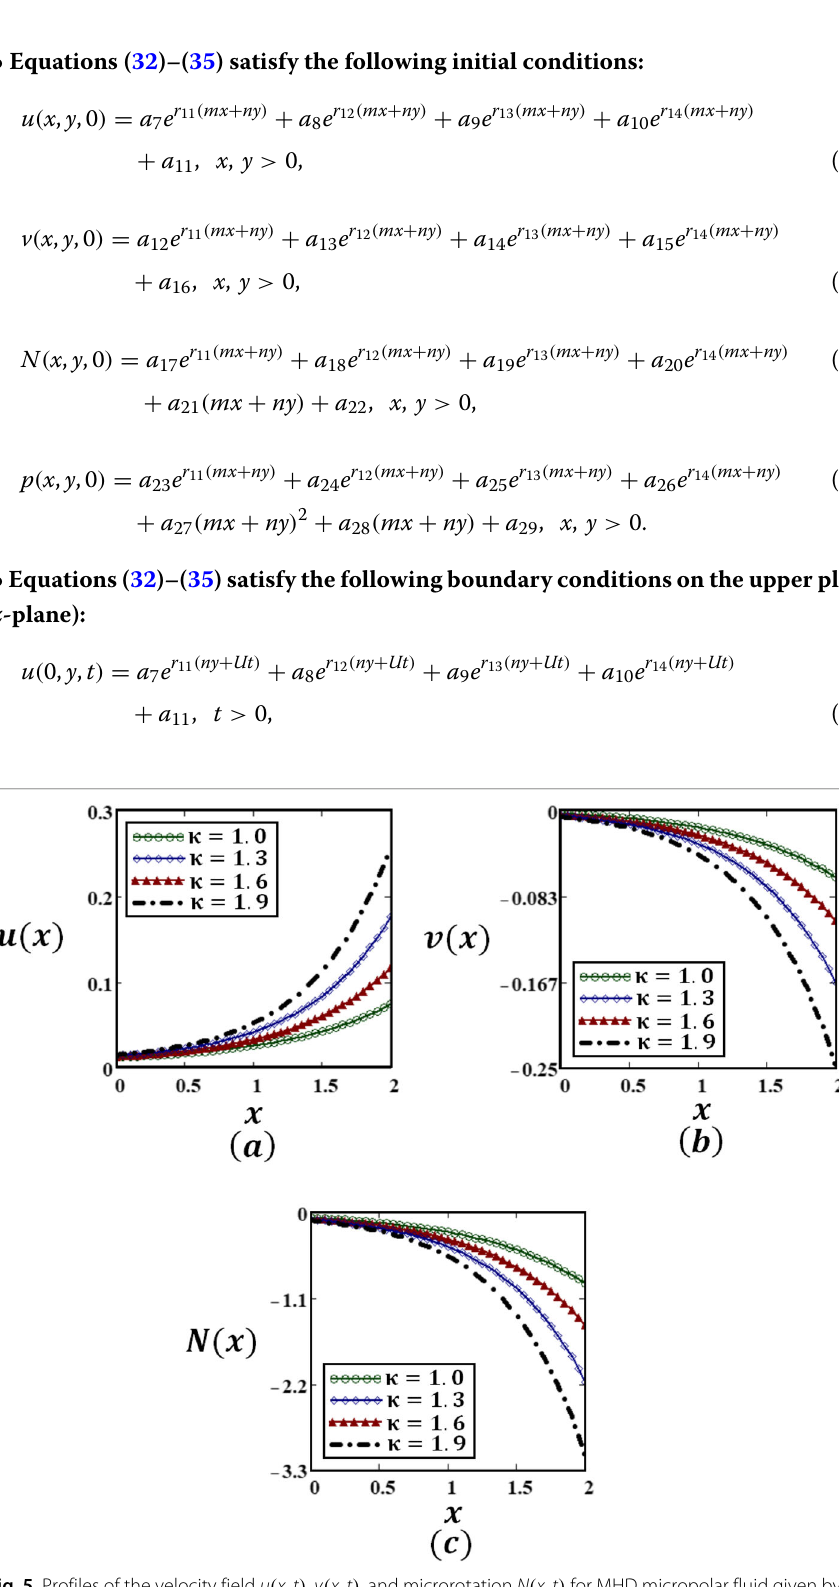
Fig. 5 Profiles of the velocity field u ( x , t ) , v ( x , t ) , and microrotation N ( x , t ) for MHD micropolar fluid given by Eqs. (32), (33), and (34), for U = 0.1, ν = 0.045, μ = 0.5, B 0 = 2, k ∗ = 0.2, σ = 0.2, j = 0.03, m = n = 1, y = 1, c 0 = 0.01, t = 2 s , and different values of